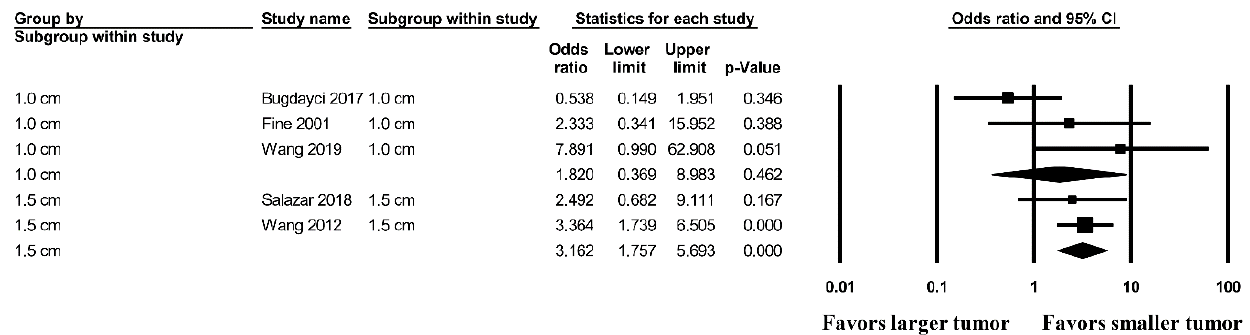
Figure 3. The odds ratio for complete resection in vacuum-assisted excision based on tumor size group.